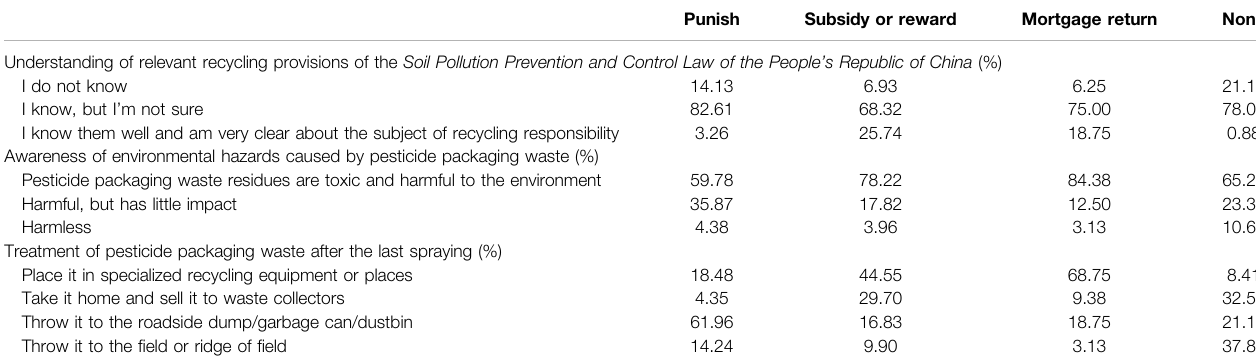
TABLE 6 | Farmers ’ awareness and recycling behavior of pesticide packaging waste in areas with different policy application